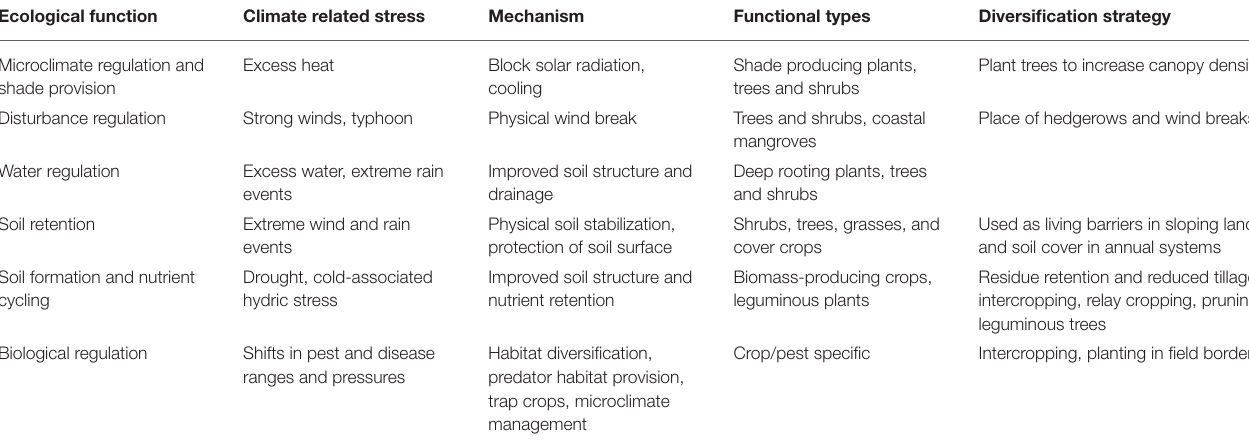
TABLE 5 | Diversification strategies to maintain or include ecological functions in farm systems. Ecological